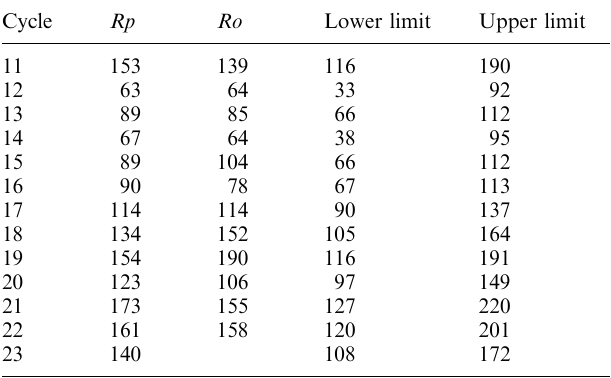
Table 1 Observed and predicted maximum sunspot